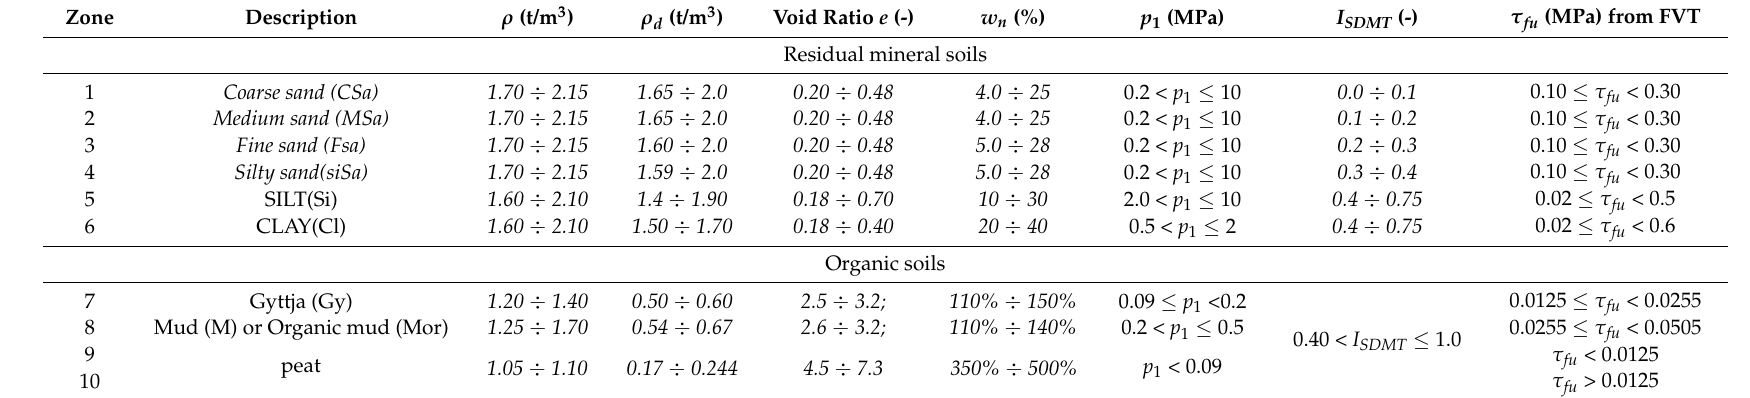
Table 4. Proposed soil classification based on I SDMT and p 1 from in situ (DMT) tests.